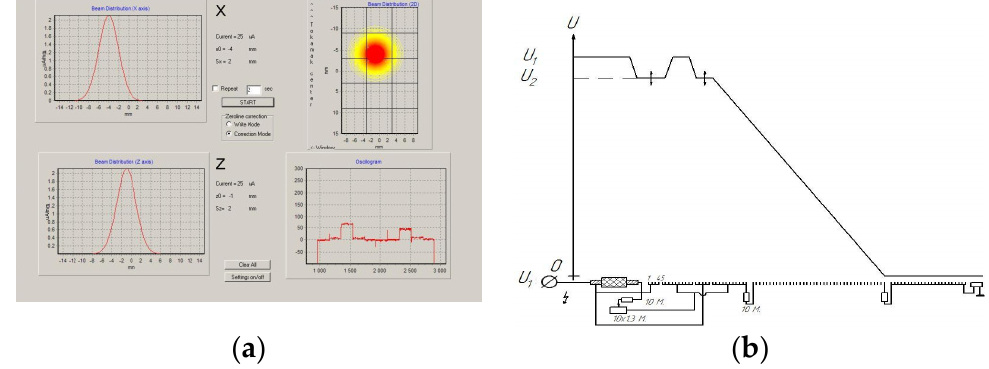
Figure 3. ( a ) Program interface for primary beam current profile measurement and visualization. ( b ) Electric potential distribution along the accelerating tube of the primary beam. Beam propagates from left (thermionic source) to right (tokamak TUMAN-3M vacuum vessel entrance).